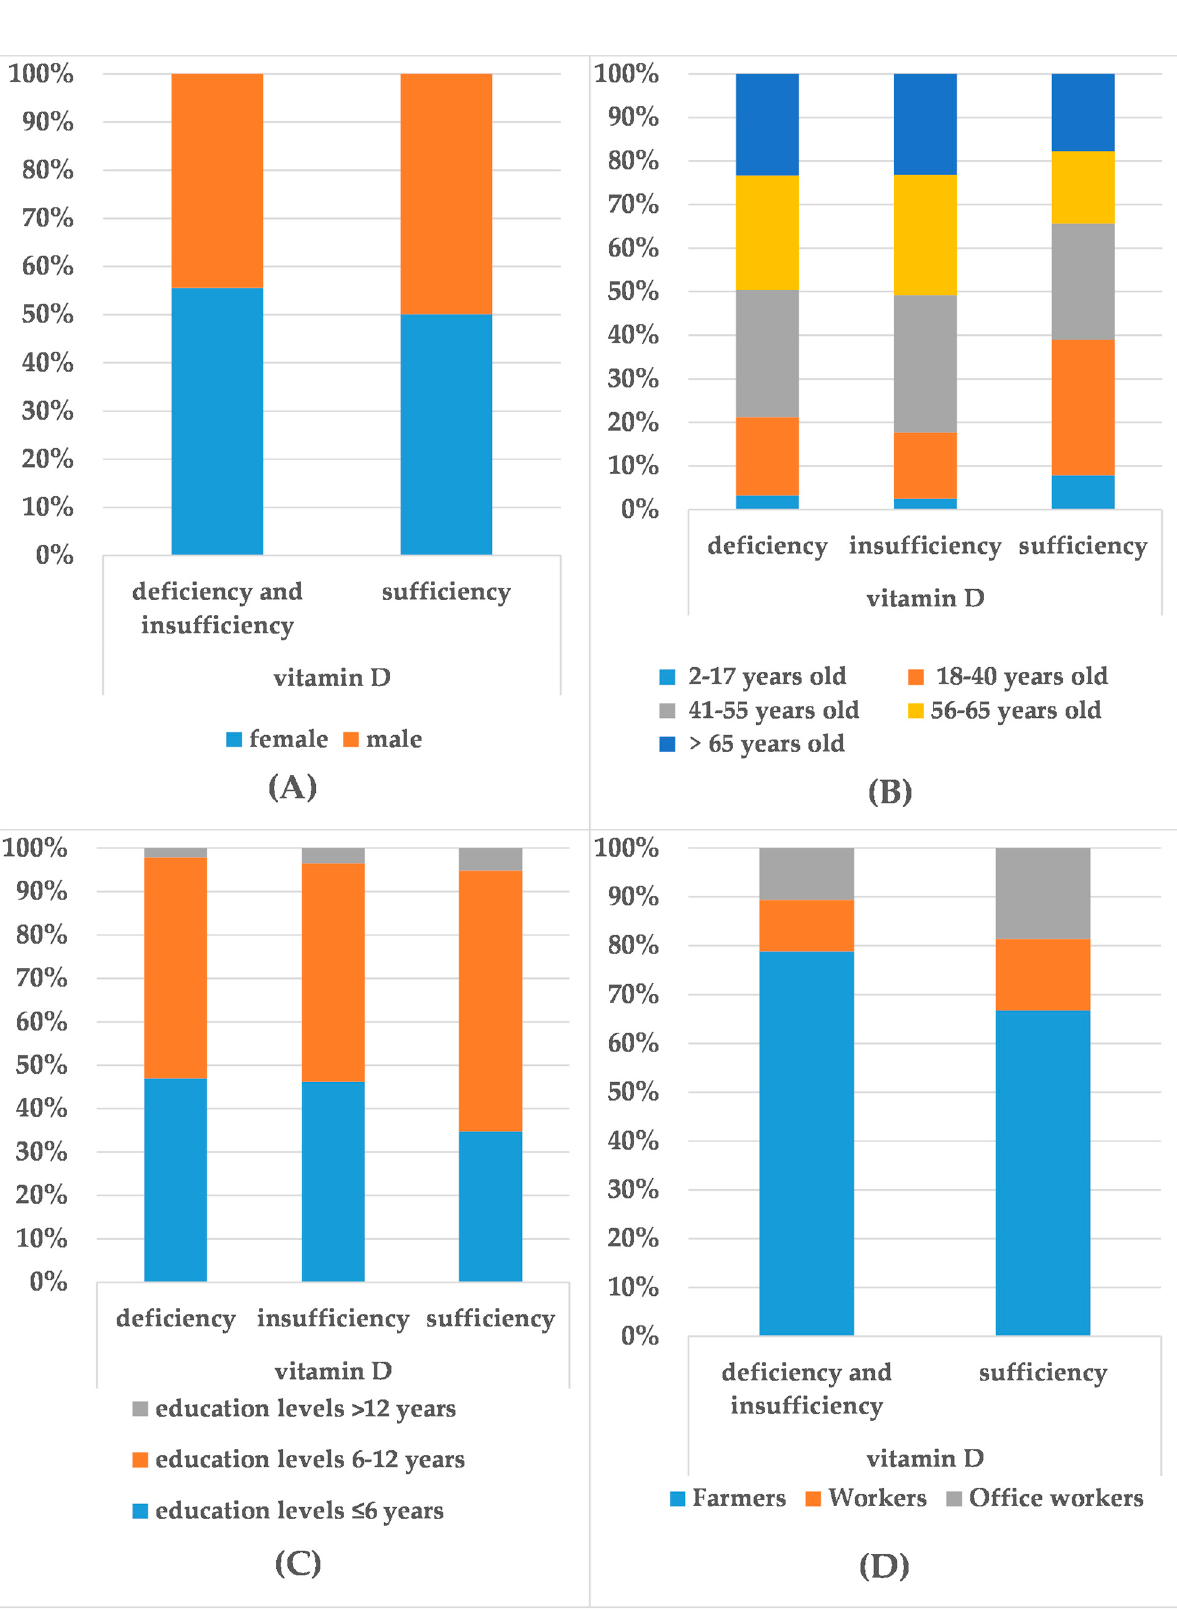
Figure 1. The proportion of the demographic characteristics in different 25(OH)D 3 levels. The proportion of gender distribution ( A ), Age (years) distribution ( B ), Education (years) levels ( C ), and Occupation distribution ( D ) in different 25(OH)D 3 levels.